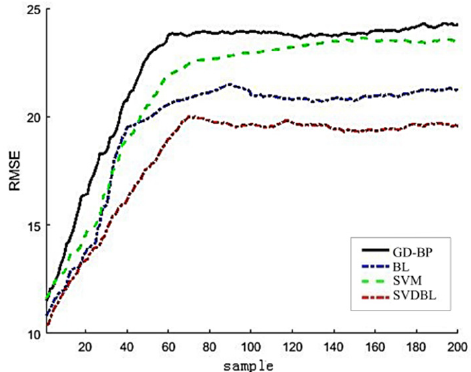
Figure 12. RMSE comparison diagram of root mean square error of four models.